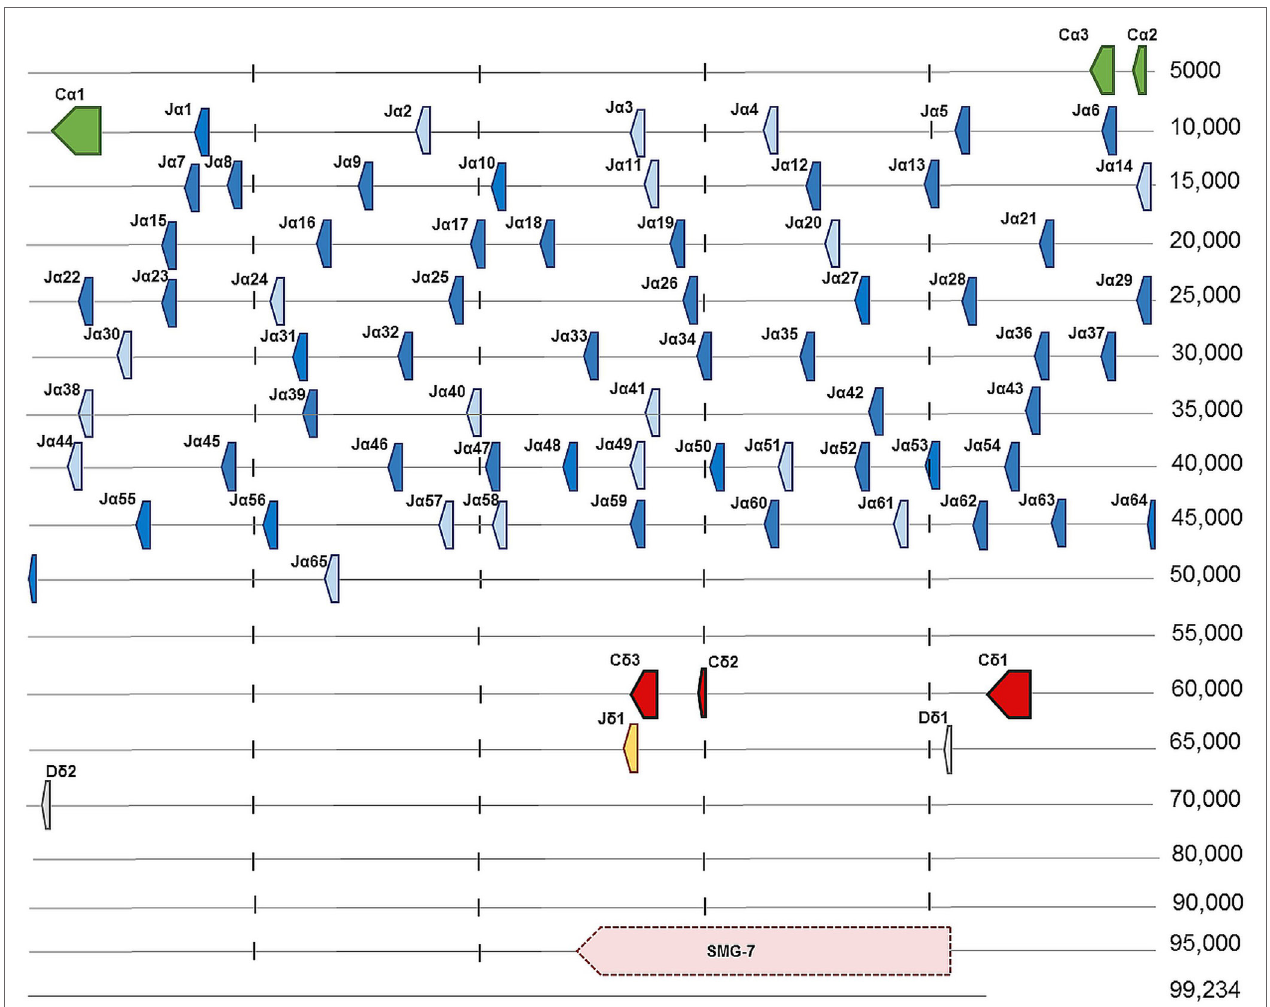
FigUre 1 | Genomic organization of the T cell receptor α / δ locus in Ballan wrasse (LaB_20160104_scaffold_928). Arrows show the direction of transcription. C α is encoded by three exons shown in green, which are followed by 65 J α segments. Light blue arrows present potential J α segments, while dark blue represent the sequences found in cDNA clones. C δ is encoded by three exons indicated here as C δ 1, C δ 2, and C δ 3. One J δ segment is shown in yellow and two D δ segments are represented in gray (D δ 1 and D δ 2). The SMG-7 gene was identified upstream of C δ and its location is shown by the pink